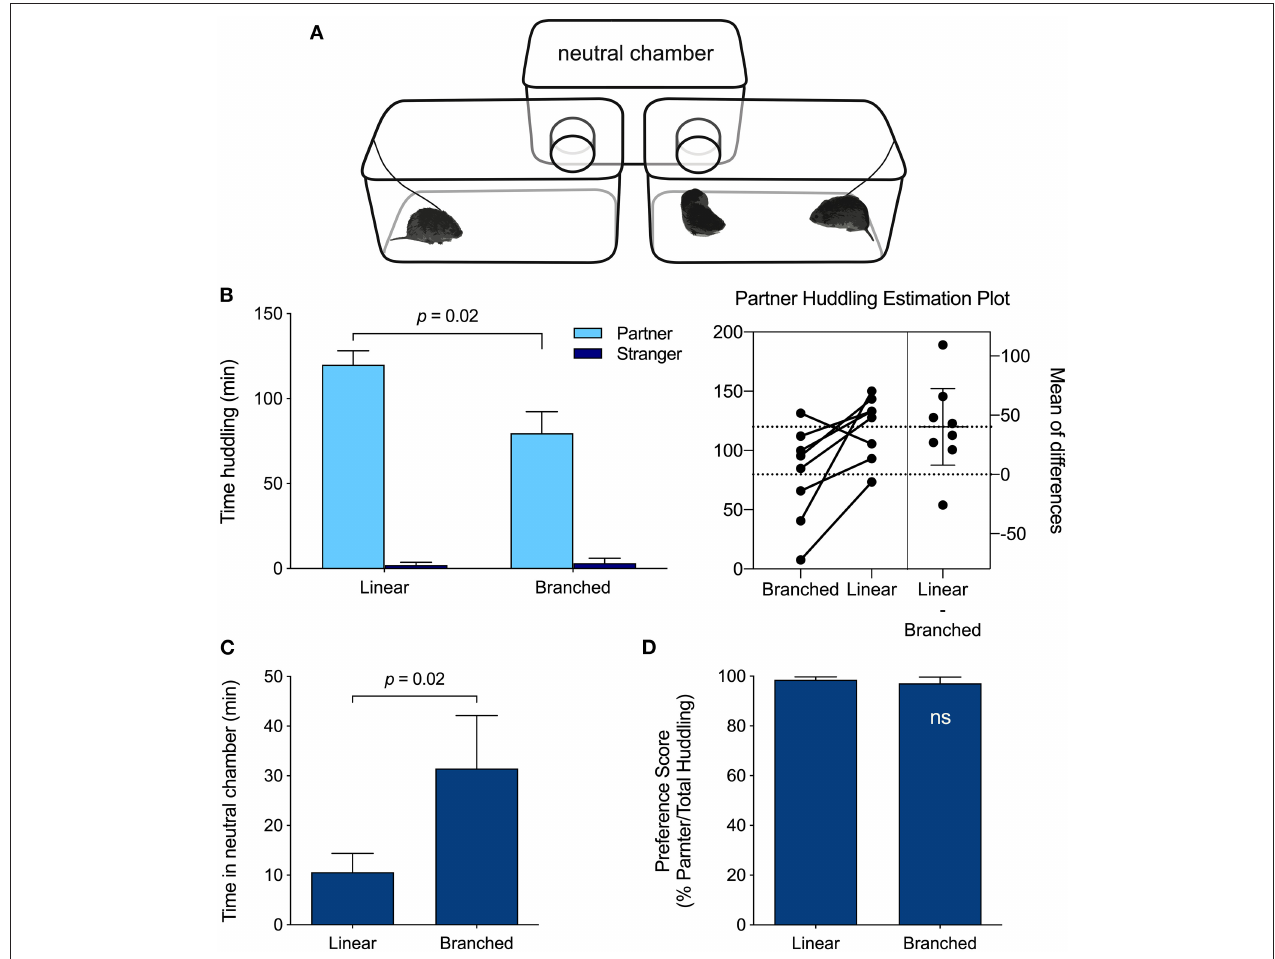
FIGURE 3 | PPT Apparatus effects. (A) Branched PPT apparatus configuration. The linear PPT apparatus appears in Figure 1 . (B) Meadow voles huddled more with their partner when tested in the linear apparatus than in the branched apparatus ( p = 0.02; paired t -test). (C) Meadow voles spent less time in the empty, neutral chamber of the linear apparatus than of the branched apparatus ( p = 0.02; paired t -test). (D) Despite differences in huddling duration, the relative preference for the partner vs. stranger did not differ across test